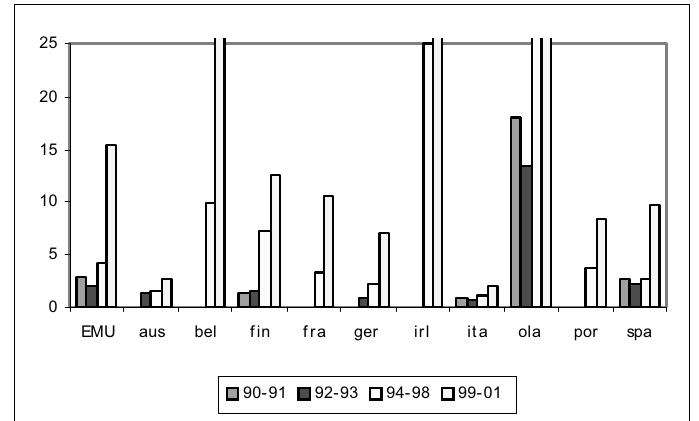
Figura 5 – Apertura finanziaria dei paesi dell’EMU, investimenti diretti (somma di investimenti diretti effettuati all’estero dai residenti e di investimenti diretti effettuati nel paese dai non residenti) in % del